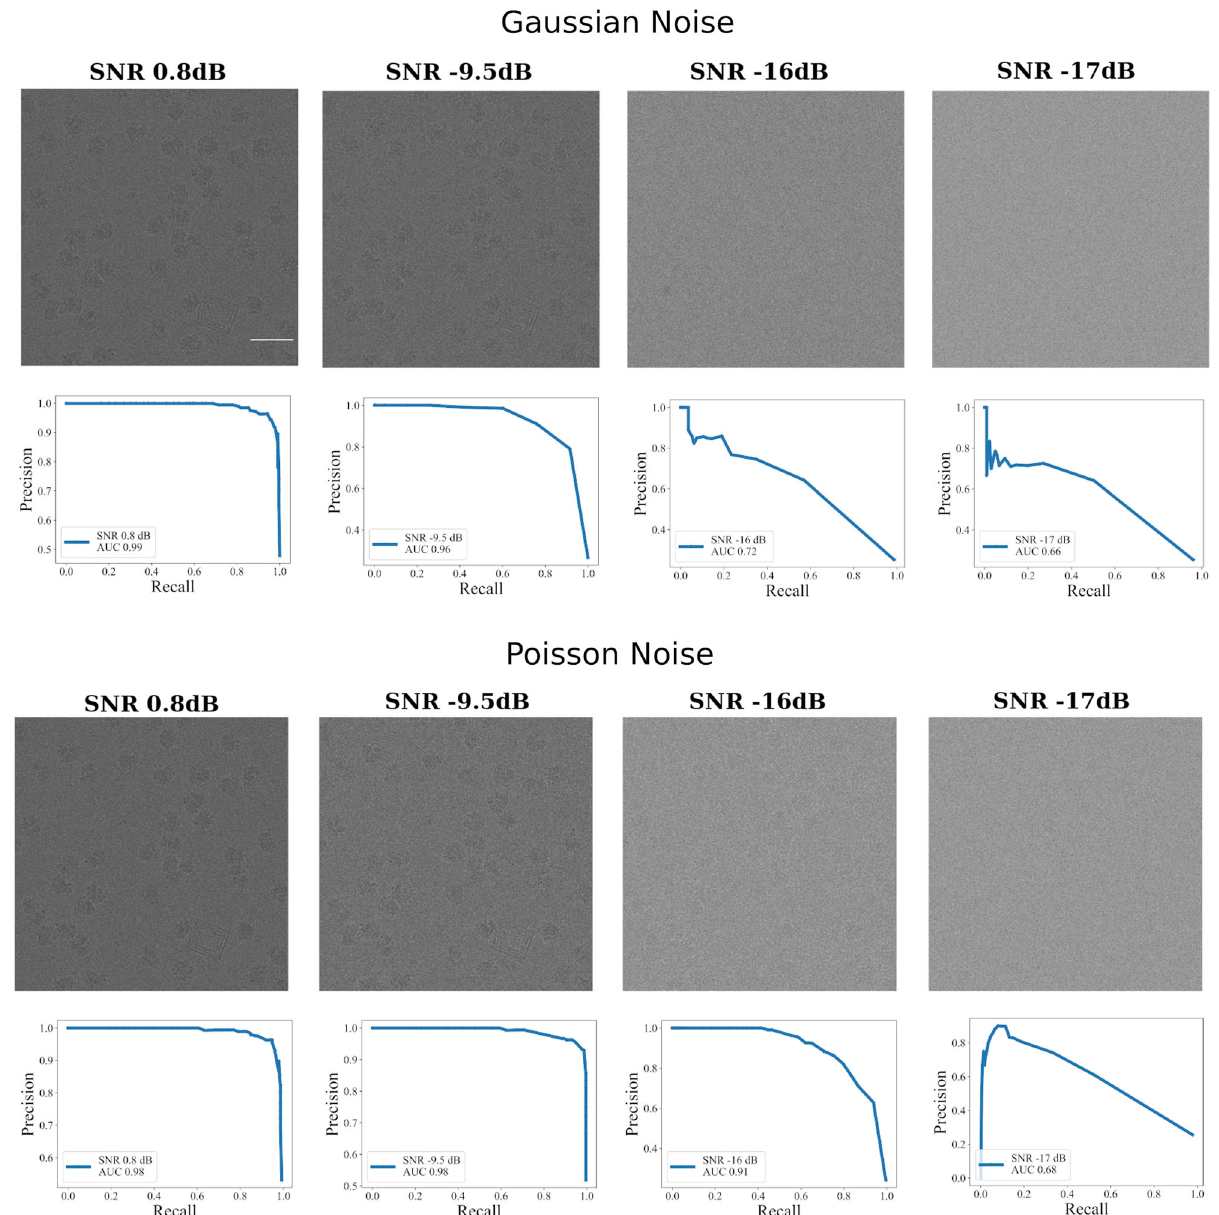
Fig. 7 Analysis of the noise dependence on performance of CASSPER cross model. A representative EMPIAR 10028 ( Plasmodium falciparum 80S ribosome bound to the anti-protozoan drug emetine) micrograph (scale bar, 50 nm) added with different levels of Gaussian and Poisson noise is shown along with the PR curve. The labels were predicted using CASSPER cross